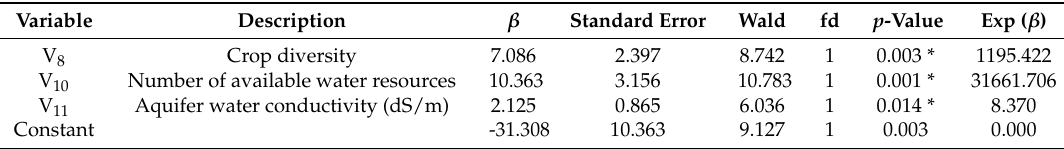
Table 4. Variables of the logistic